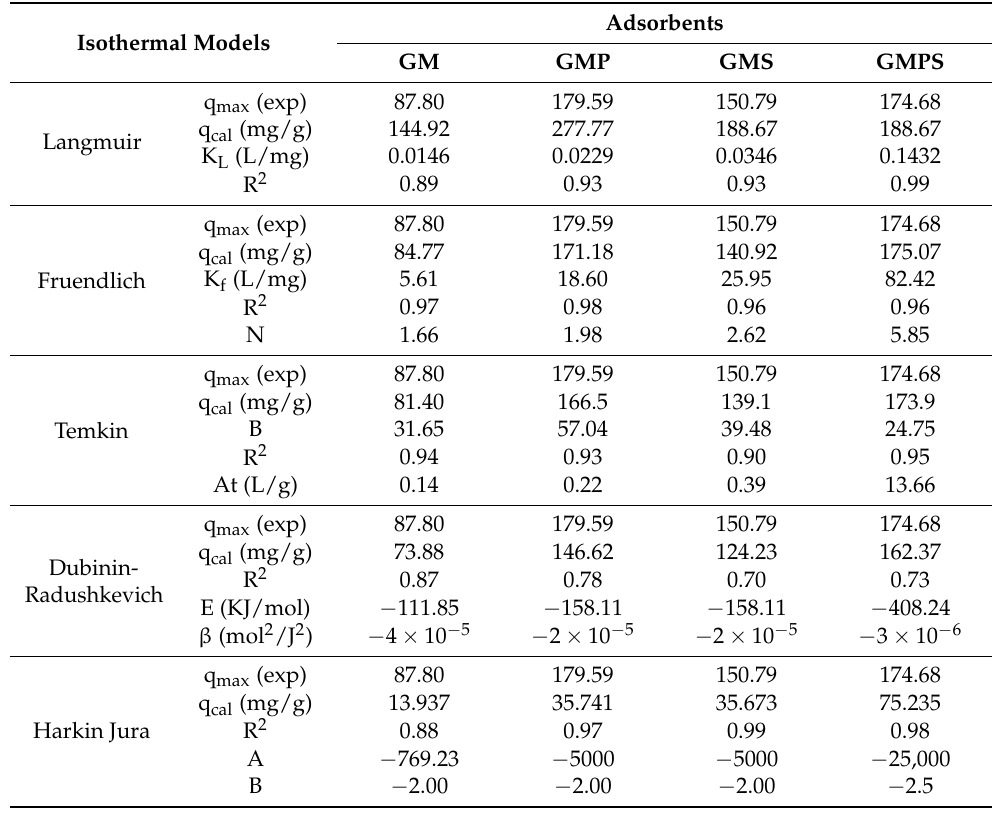
Table 1. Comparison of Langmuir, Fruendlich, Temkin, Dubinin-Radushkevich, and Harkin Jura isotherms for Foron black